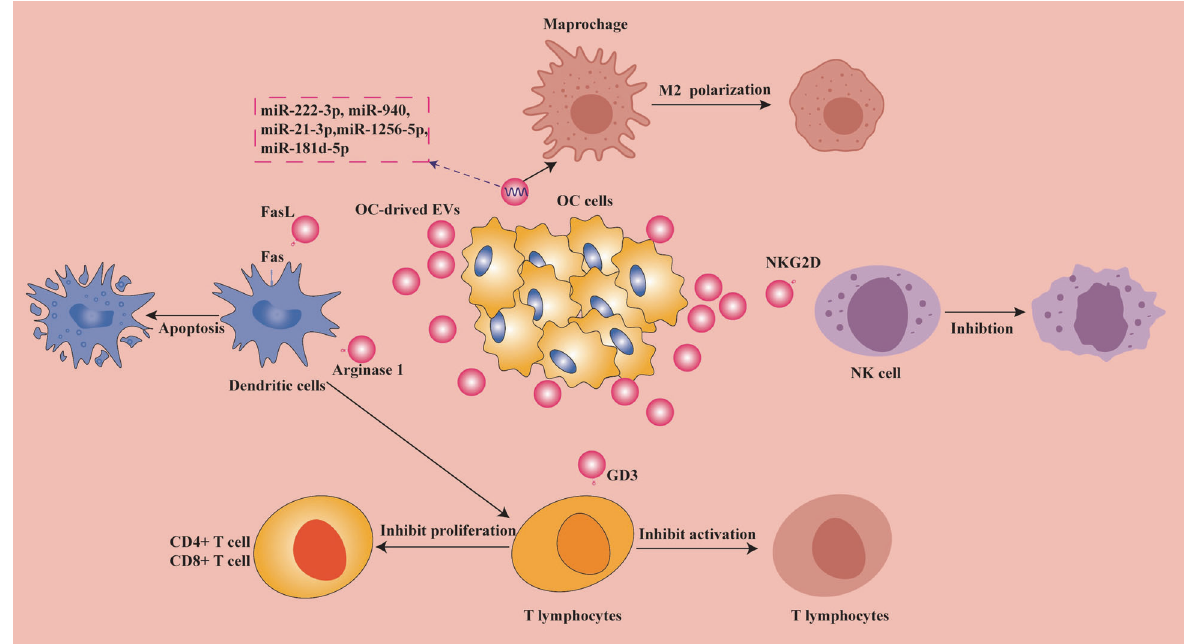
Fig. 3 The role of EVs in OC immune evasion. OC-derived EVs inhibit the activation of DC cells, induce the polarization of macrophages, inhibit the cytotoxicity of NK cells, and regulate the function of T cells. The miRNAs carried in EVs secreted by OC cells promote the conversion of macrophages into M2 phenotype [124], and the FasL carried on the surface induces the apoptosis of DCs [128]. EV cargo also inhibits the proliferation of CD4 + and CD8 + T cells through the presentation of DCs [145]. EV cargo directly stimulates T cells and NK cells as well as inhibits their functional activation [136, 144]. EVs help OC cells produce immune evasion through these mechanisms of